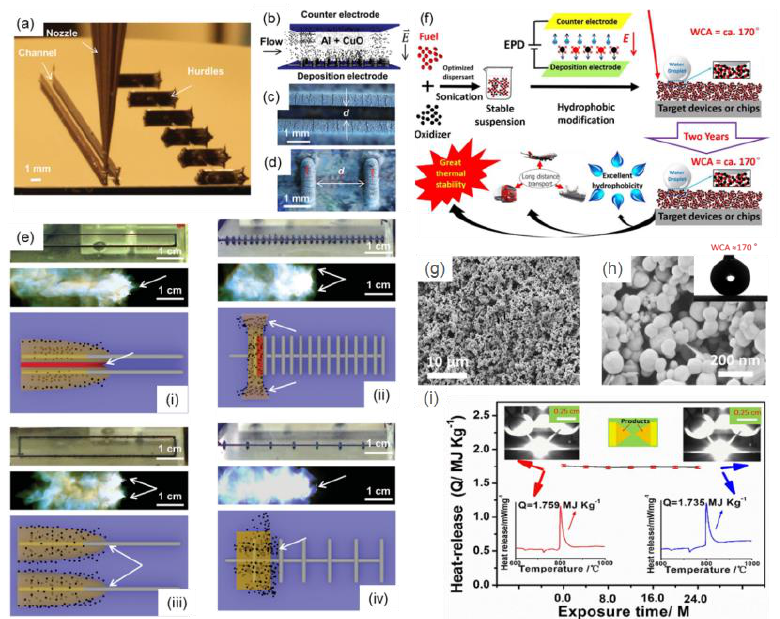
Figure 8. ( a ) Optical image of 3D printing process for channels (left) and hurdles (right) composed of silver nanoparticle ink, ( b ) schematic illustration of the electrophoretic assembly process of Al/CuO EMs onto the electrode surfaces, ( c ) optical images (top view) of a channel, ( d ) hurdle ar- chitectures after deposition of Al/CuO film, ( e ) optical image of four kinds of channel and hurdle structures, followed by the corresponding combustion process and the resultant pressurization re- gion and expansion process illustration [104] Copyright 2016, Advanced Materials; ( f ) the sche- matic diagram of the fabrication of superhydrophobic Al/Bi 2 O 3 films, the SEM images (( g ) low res- olution and ( h ) high resolution) of product, and ( i ) the thermal stability property of product after different exposure time. Inset, DSC and ignition tests reveal the exothermic performance of prod- ucts before and after two years exposure [111], Copyright 2018, Chemical Engineering Journal.